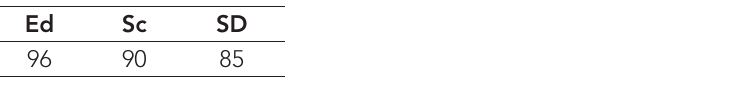
Table 9: Agreed that theory is ‘important to us as teachers’